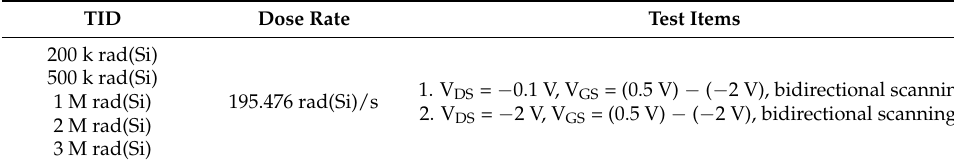
Table 1. Measurement information in this paper.